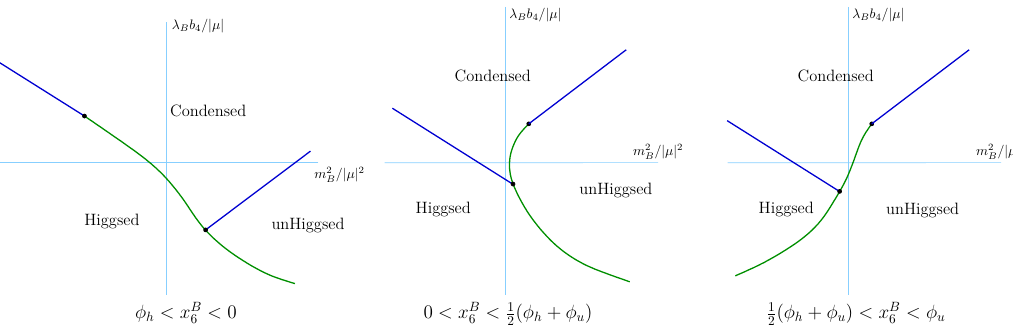
Figure 4 . Phase diagram for the regular boson theory at zero temperature for various subranges of the stable range φ h < x B < φ u . Refer to (7.14) for the definitions of φ u and φ h . The blue lines 6 are second order transitions while the green lines are first order transitions. Actual numerical plots of the above phase diagrams can be found in section 7.7 in figures 20, 21 and